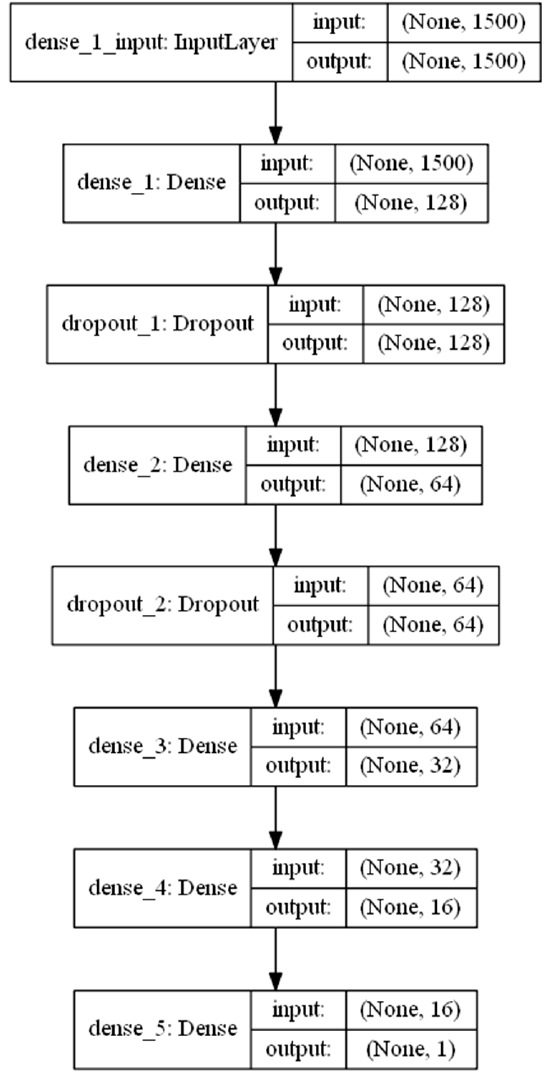
Figure 3. Architecture of a single designed deep learner.